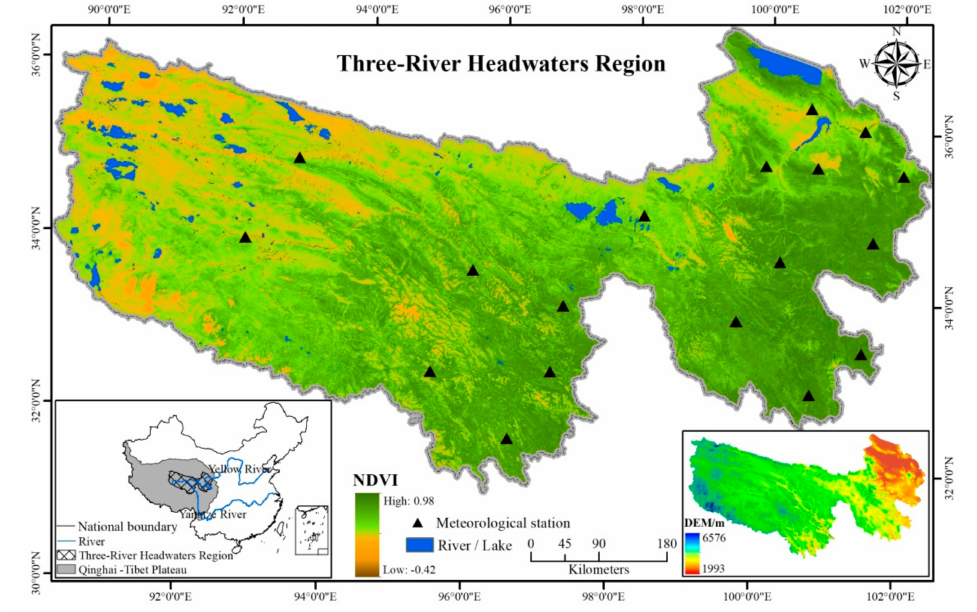
Figure 1. Location of the study area including 18 meteorological stations and digital elevation model data